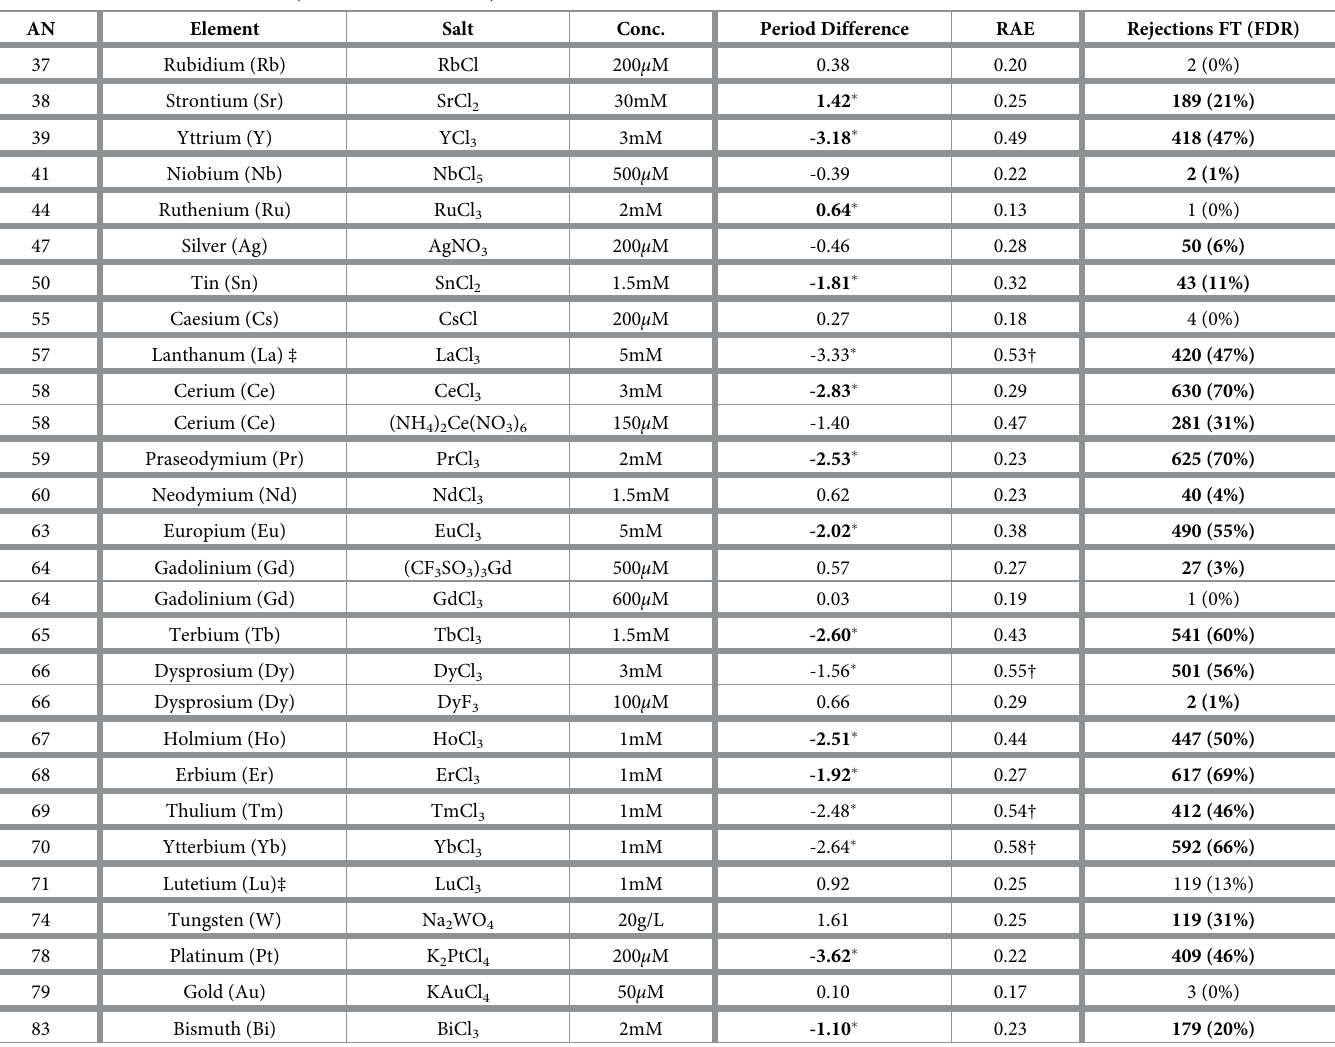
Table 3. Extension chemicals: Part 2 (atomic numbers